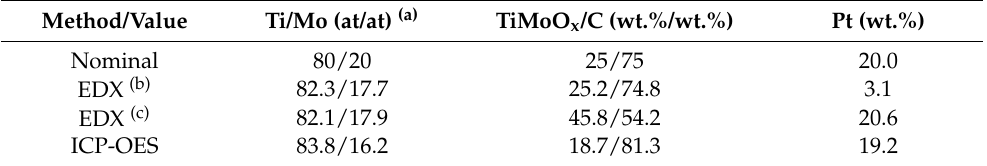
Table 2. Composition of the Pt/75BP electrocatalyst calculated from EDX and ICP-OES results in comparison with nominal